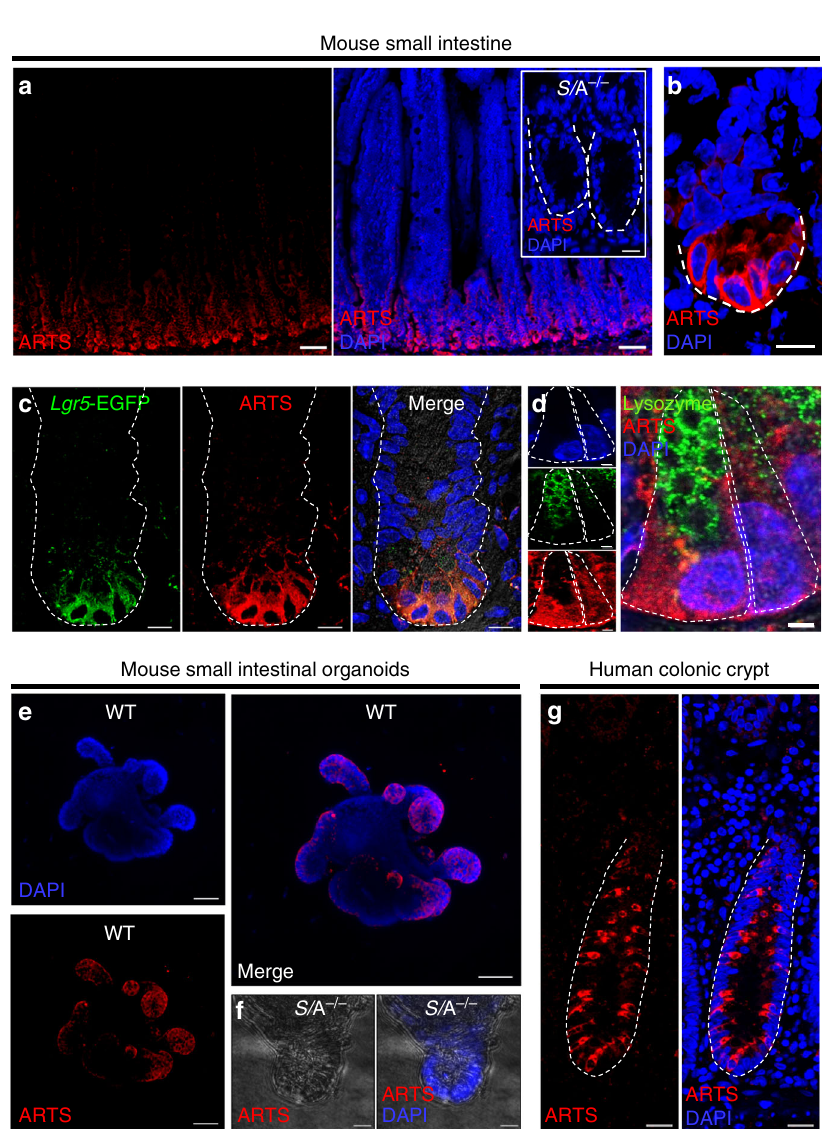
Fig. 1 Expression of ARTS is enhanced in intestinal crypt cells. a Immuno fl uorescence (IF) using an antibody speci fi cally against the Sept4 isoform ARTS reveals high expression in wild-type (WT) intestinal crypts. Inset shows Sept4 /ARTS − / − ( S /A − / − ) control crypts stained for ARTS. b Image of single zoomed-in crypt housing ARTS + cells at the crypt base. Dashed white line demarcates crypt base. c Single mouse small intestinal crypt stained for Lgr5 - EGFP + intestinal stem cells (ISCs) and ARTS. d Zoom-in of two crypt base cells including lysozyme + Paneth cell and lysozyme − crypt base columnar (CBC) cell stained for ARTS. e Mouse small intestinal organoid at high passage stained for ARTS shows heightened expression in de novo organoid crypts. f S /A − / − negative control organoid crypt stained for ARTS. g Normal human colonic crypt shows an alternating pattern of ARTS + cells in the crypt. Images are representative of n = 3 human colons, n = 3 mice or well triplicates of organoids generated from 3 pooled mouse intestines. White dashed lines demarcate whole intestinal crypts or crypt base cells, unless otherwise indicated. All experiments were repeated at least twice. Scale bars: 5 µ m ( d ), 10 µ m ( a inset, b , c , f ), 20 µ m ( g ), 50 µ m ( a , e